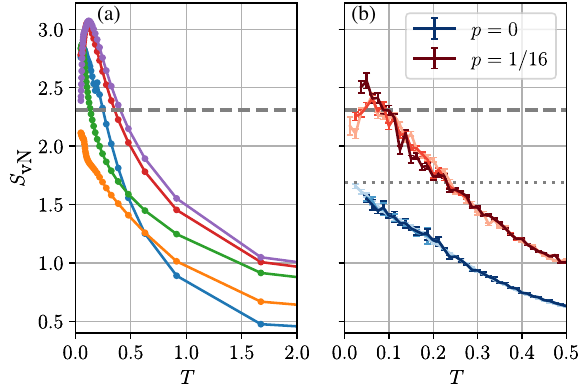
FIG. 11. METTS entanglement entropy S on the 32 × 4 vN cylinder at U=t ¼ 10 (a) entanglement growth upon time evolv- 4000 . ing five different product states for p ¼ 1 = 16 with D max ¼ (b) Average entanglement entropy S of the METTS state as a vN function of the temperature for p ¼ 0 and p ¼ 1 = 16 . Increas- ing opacity signifies increasing maximal bond dimensions D 2000 , 3000, 4000. We observe a small peak in the max ¼ entanglement entropy in the hole-doped case at T=t ≈ 0 . 05 . The entanglement entropy is converged as a function of the bond dimension. The dashed (dotted) lines indicate the entanglement 4000 at p ¼ entropy from ground-state DMRG with D max ¼ 1 = 16 ( p ¼ 0